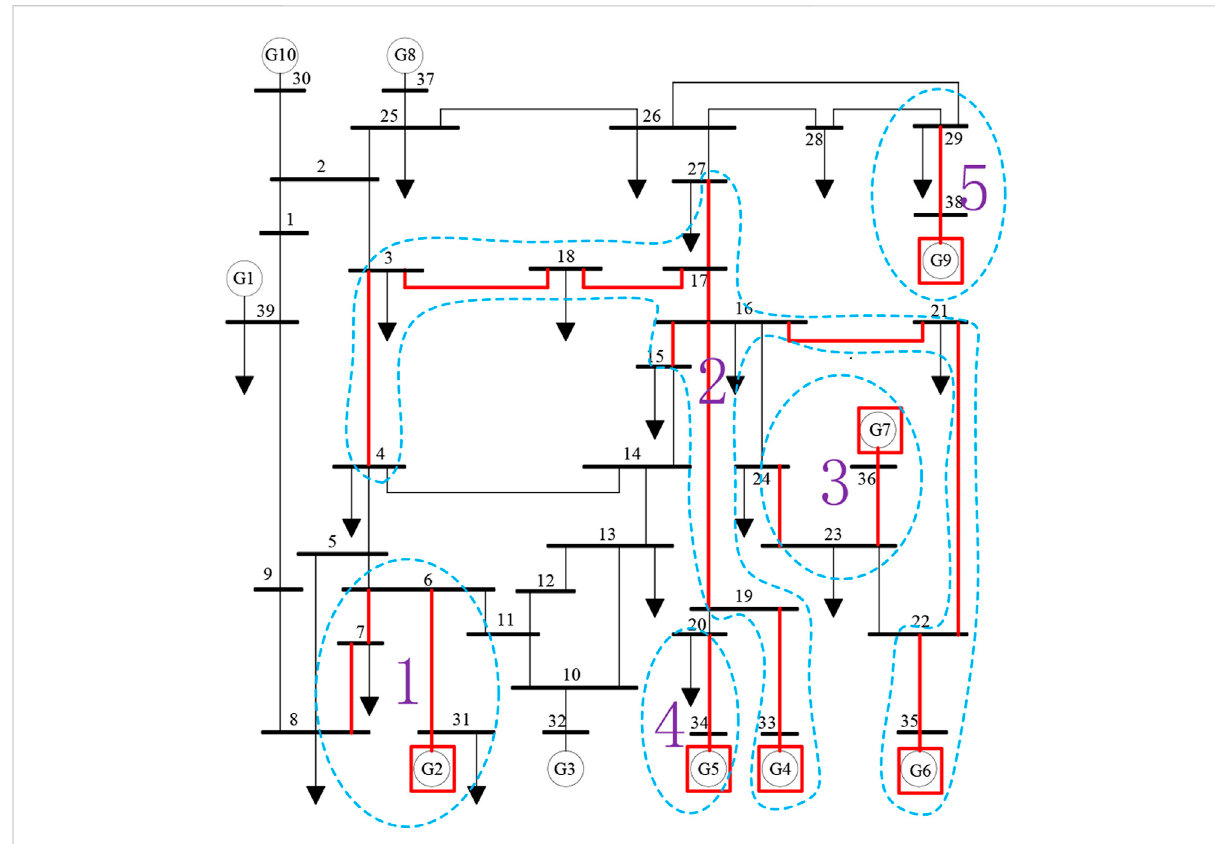
FIGURE 3 IEEE 39-bus system backbone grid without connectivity